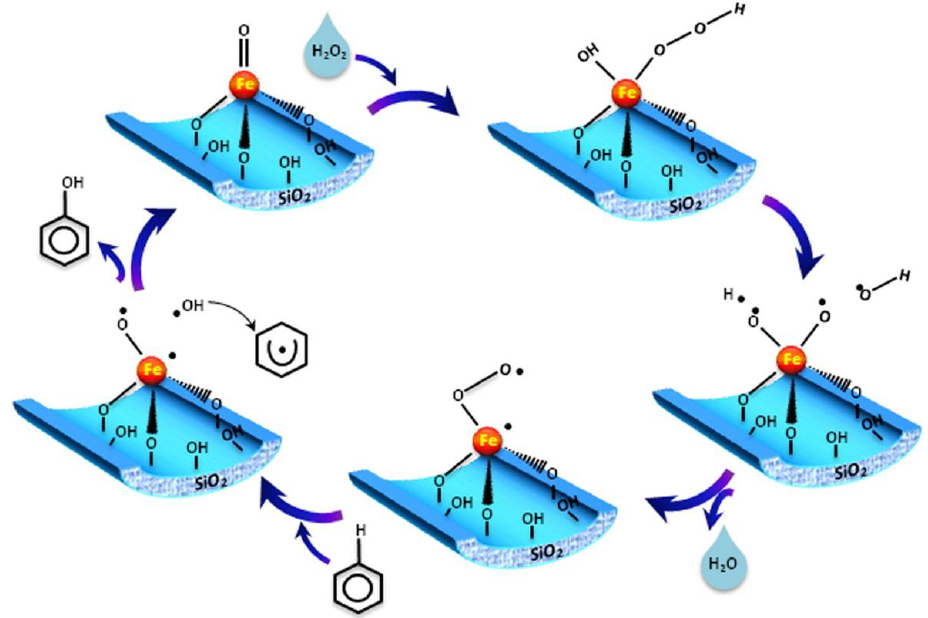
Figure 14. Mechanism of the Catalytic Benzene Hydroxylation by H 2 O 2 in the Presence of Fe/SBA-16. Reprinted with permission from [116], Copyright 2016, American Chemical Society. Reprinted with permission from [116], Copyright 2016, American Chemical